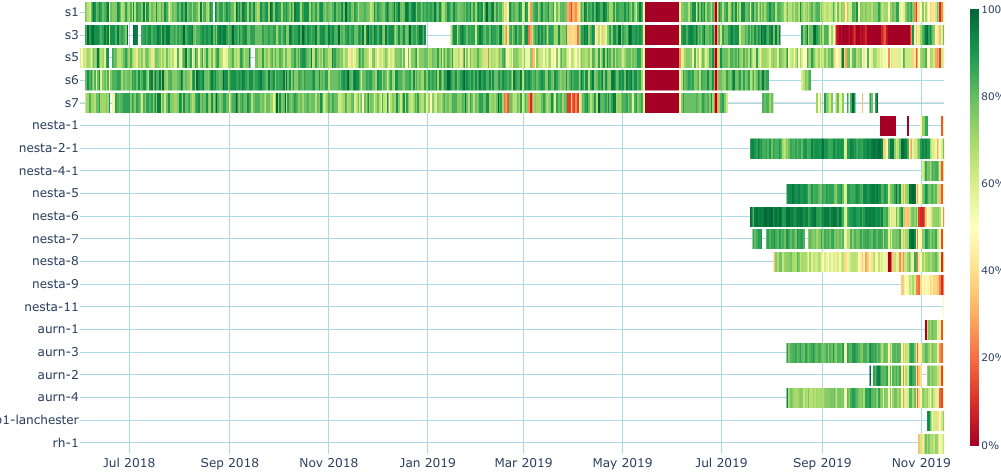
Figure 2. Percentage of LoRaWAN messages received per day for the system as a whole, including: station LoRaWAN transmit, The Things Network (TTN), MQTT receiver, and application storage server). Not all stations were deployed at the same time, and some have been offline for periods of time. The server side data logger failed 14th May–5th June 2019, resulting in a loss of messages. Node rh-1 uses Adaptive Data Rate (ADR) and acknowledgements so is not directly comparable to the other